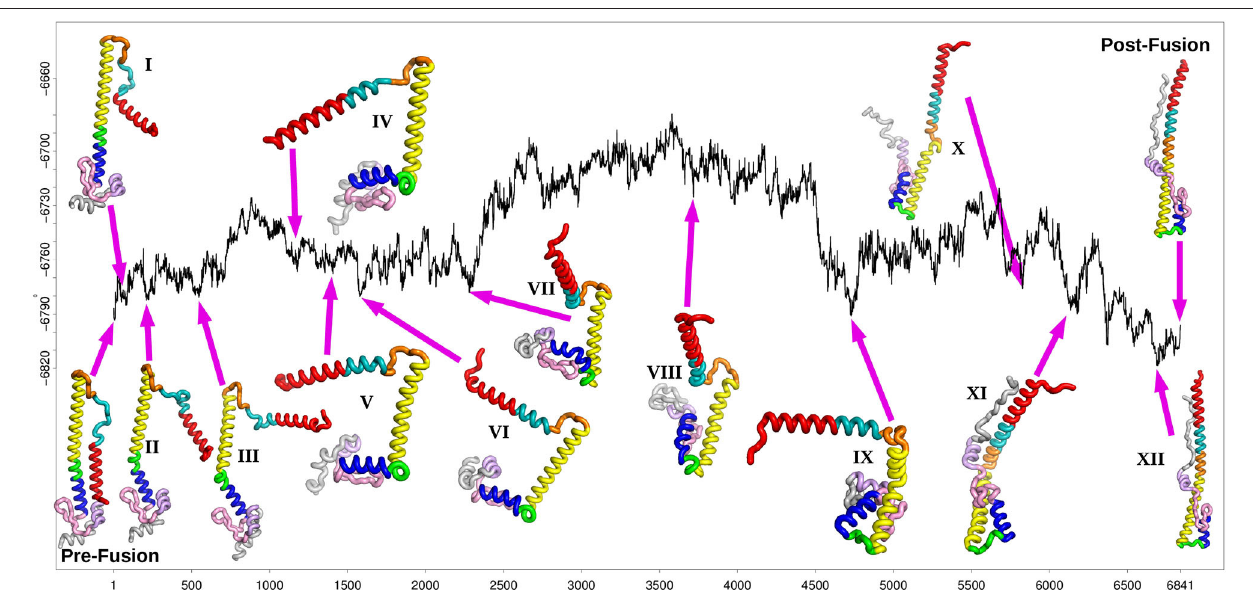
FIGURE 3 | Fastest path after refinement of the database, with selected local minima illustrated for the stationary points at position 81(I), 223(II), 541(III), 1183(IV), 1391(V), 1577(VI), 2283(VII), 3717(VIII), 4737(IX), 5829(X), 6137(XI), and 6693(XII) (the post-fusion end point minimum). The relative energy in kcal/mol is plotted against the number of stationary points, as in Figure 2